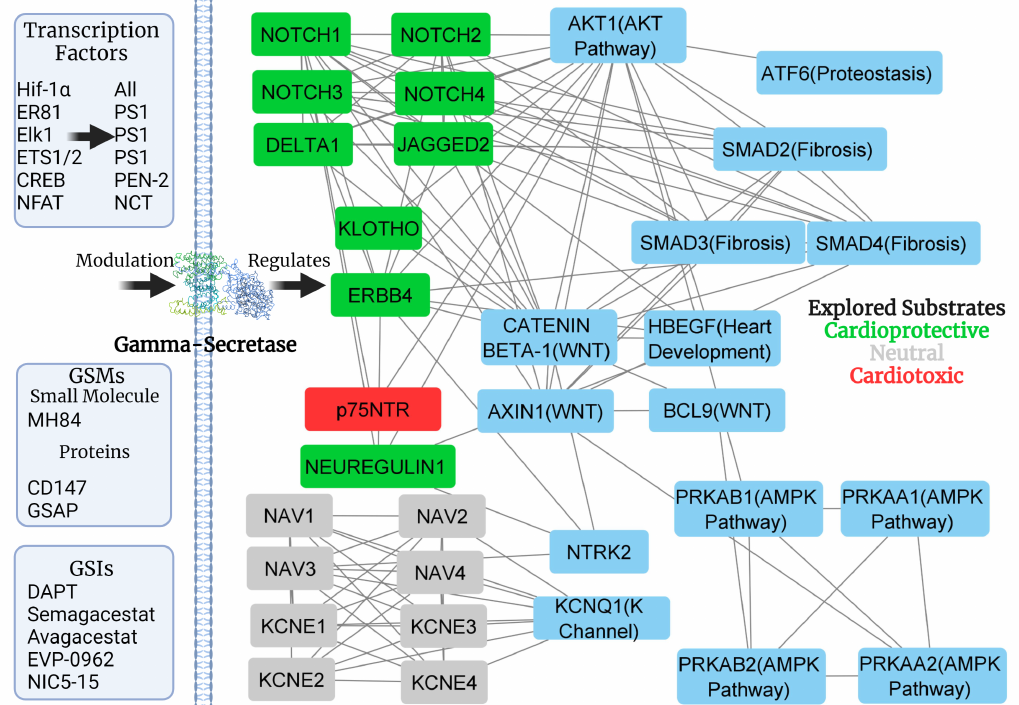
Figure 3. Examples of transcription factors [51,133,134] (and corresponding targets), gamma-secretase modulators (GSMs) [6,50,135,136], and inhibitors (GSIs) with the potential of changing gamma-secretase activity; affecting the subse- quent inter-connected signaling pathways. The protein–protein interaction network includes the substrates of interest and 16 other interacting partners to create a network with a path between every